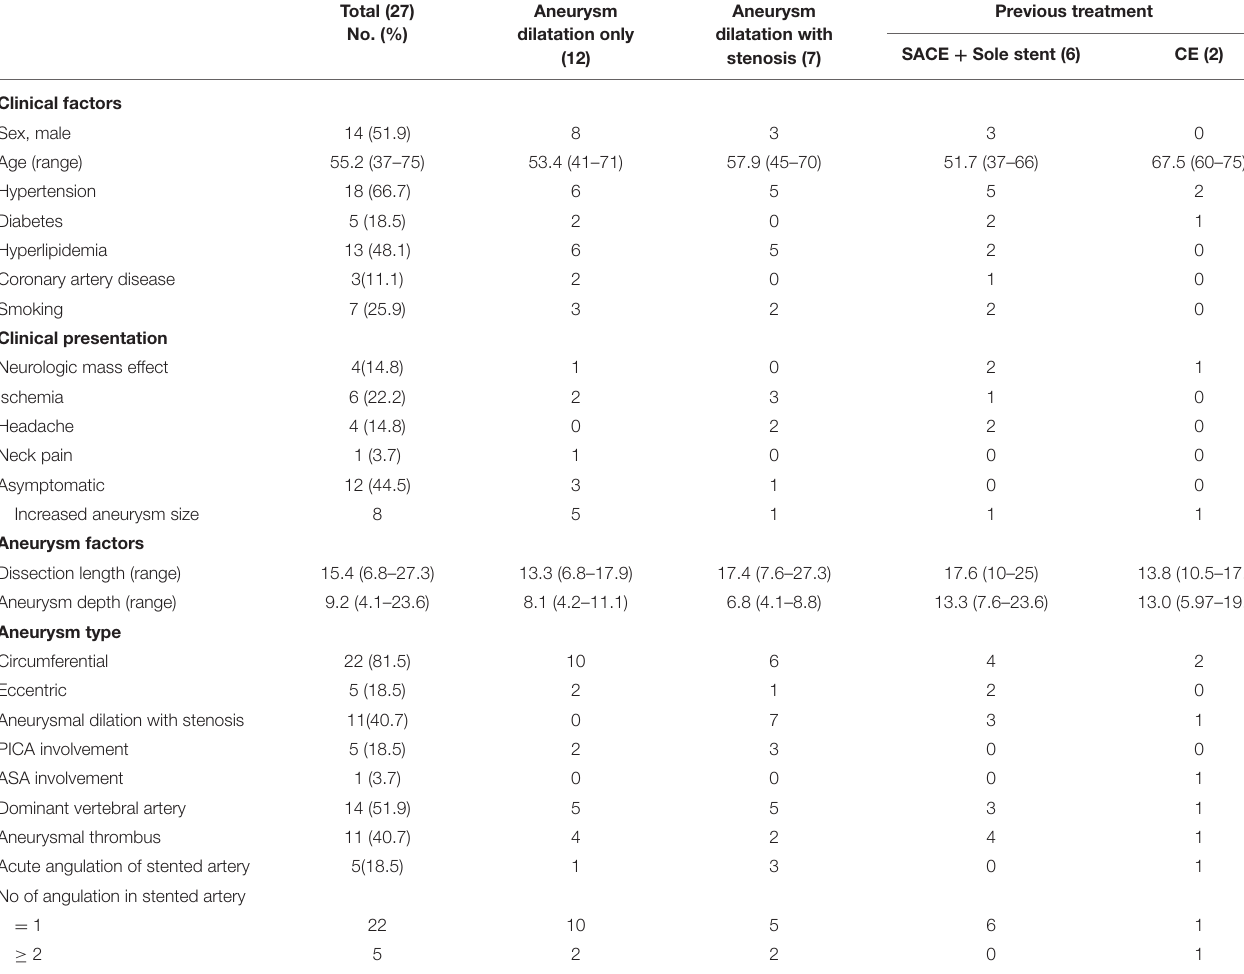
TABLE 1 | Clinical and radiologic characteristics of subjects depending on the various